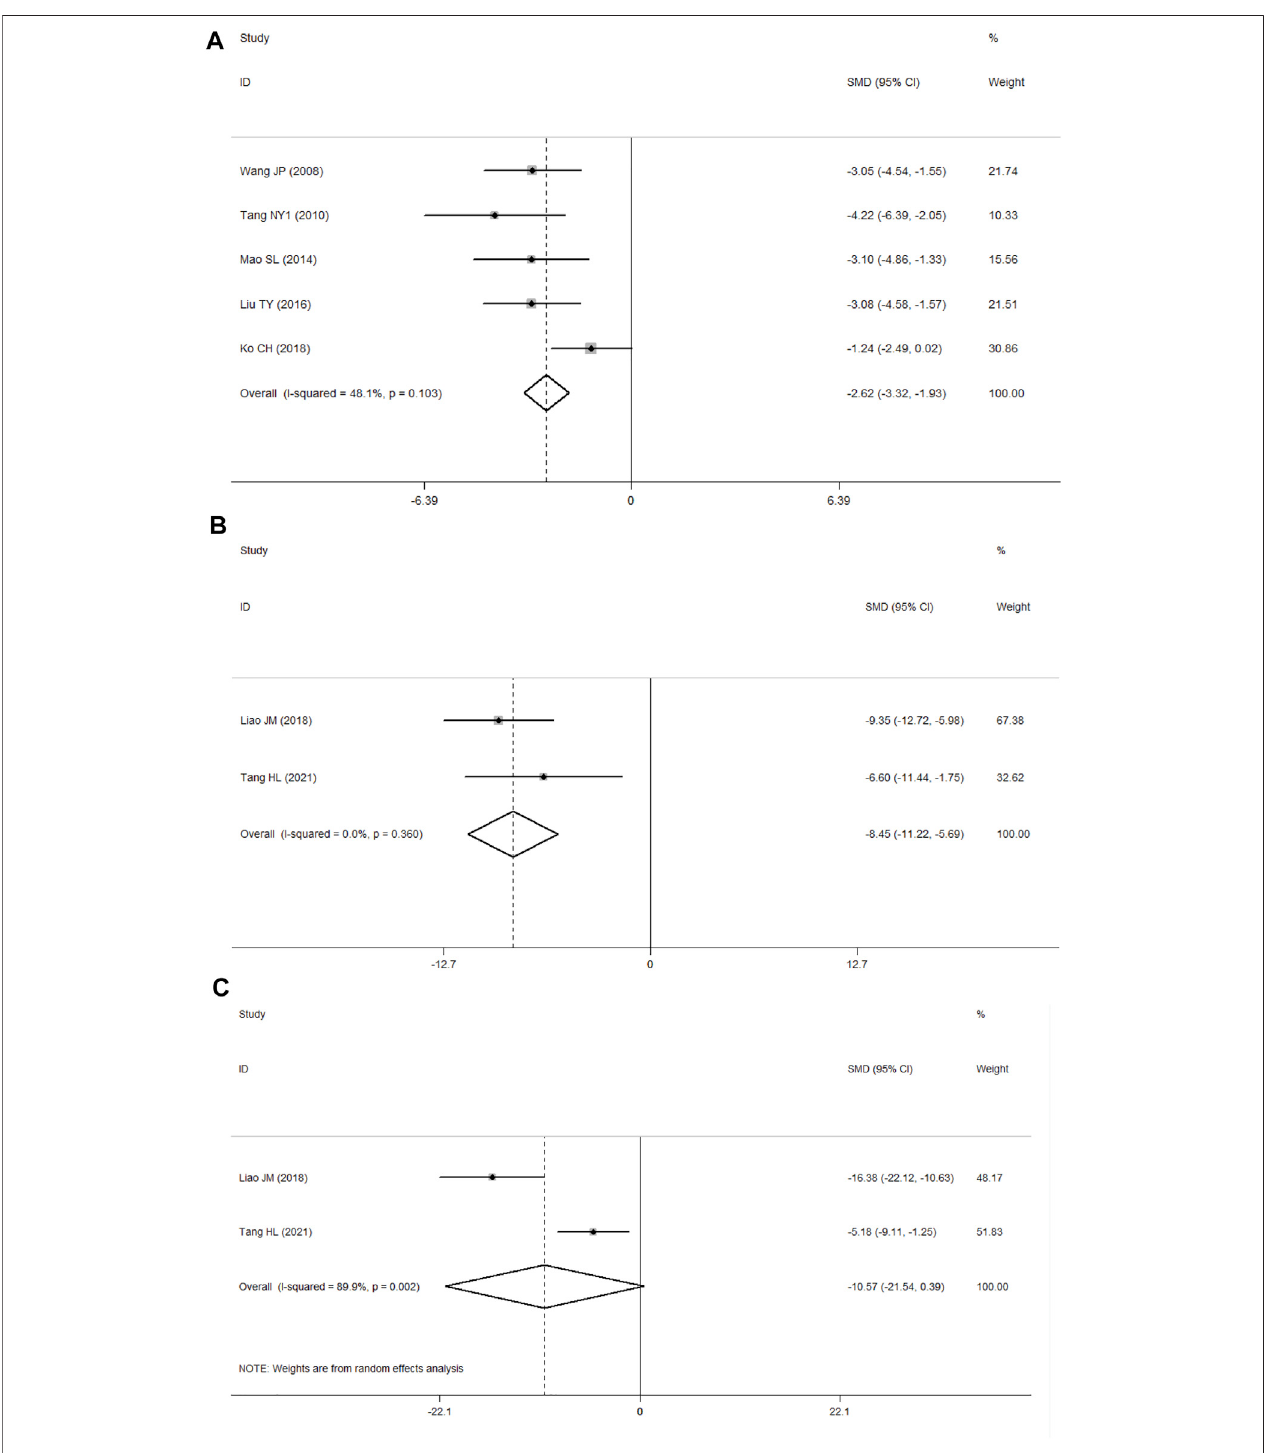
FIGURE 7 | (A) Forest plots of PF for TUNEL staining; (B) forest plots of PF for IL-1 β ; (C) forest plots of PF for TNF- α .